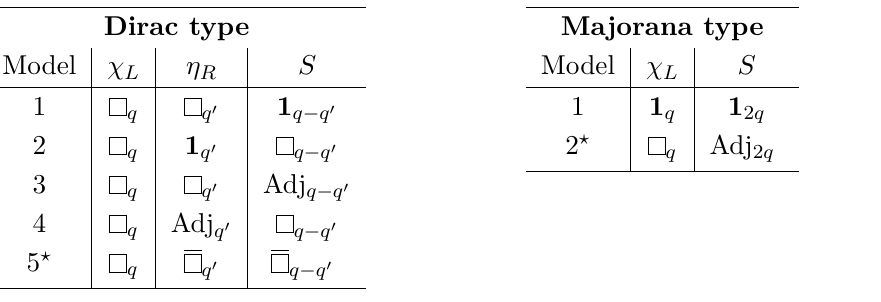
Table 1 . Dirac type and Majorana type theories described by the Lagrangians of eq. (3.1) and eq. (3.2), respectively. If S is either a singlet or transforms in the adjoint representation of SU( N ) and also has a vanishing U(1) charge, then it is a real scalar field. Model 5 of the first class is only present in the case of SU(3) , while model 2 of the second class only in the case of SU(2)